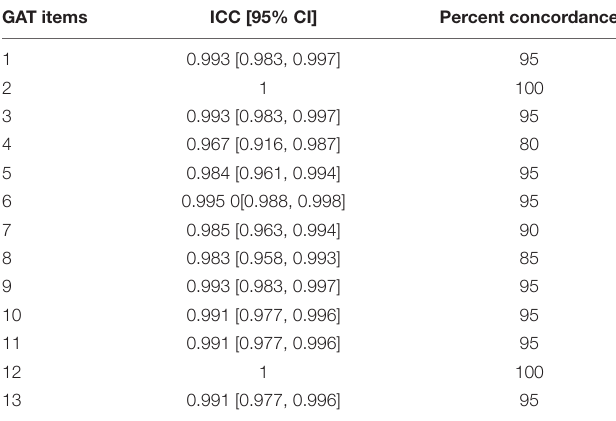
TABLE 4 | Correlation between Grounding Assessment Tool (GAT) items and total scores, and Cronbach’s alpha value when item is deleted ( N = 43). GAT items